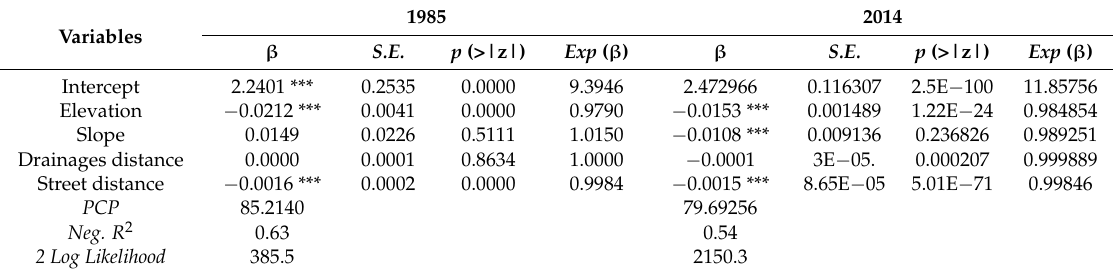
Table 3. Estimated results of the logistic regression model in Jeddah of the four independent variables.